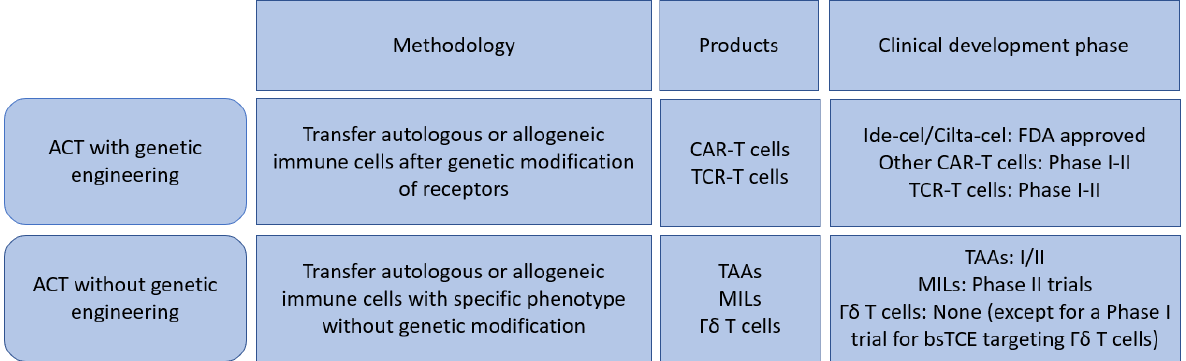
Figure 1. Summary of T-cell-based therapy for Multiple Myeloma. ACT: Adoptive cell transfer; CAR: Chimeric antigen receptor; TCR: T-cell receptor; TAAs: Tumor associated antigen targeted T-cells; MILs: Marrow infiltrating lymphocytes; bsTCE: bispecific T-cell engager.